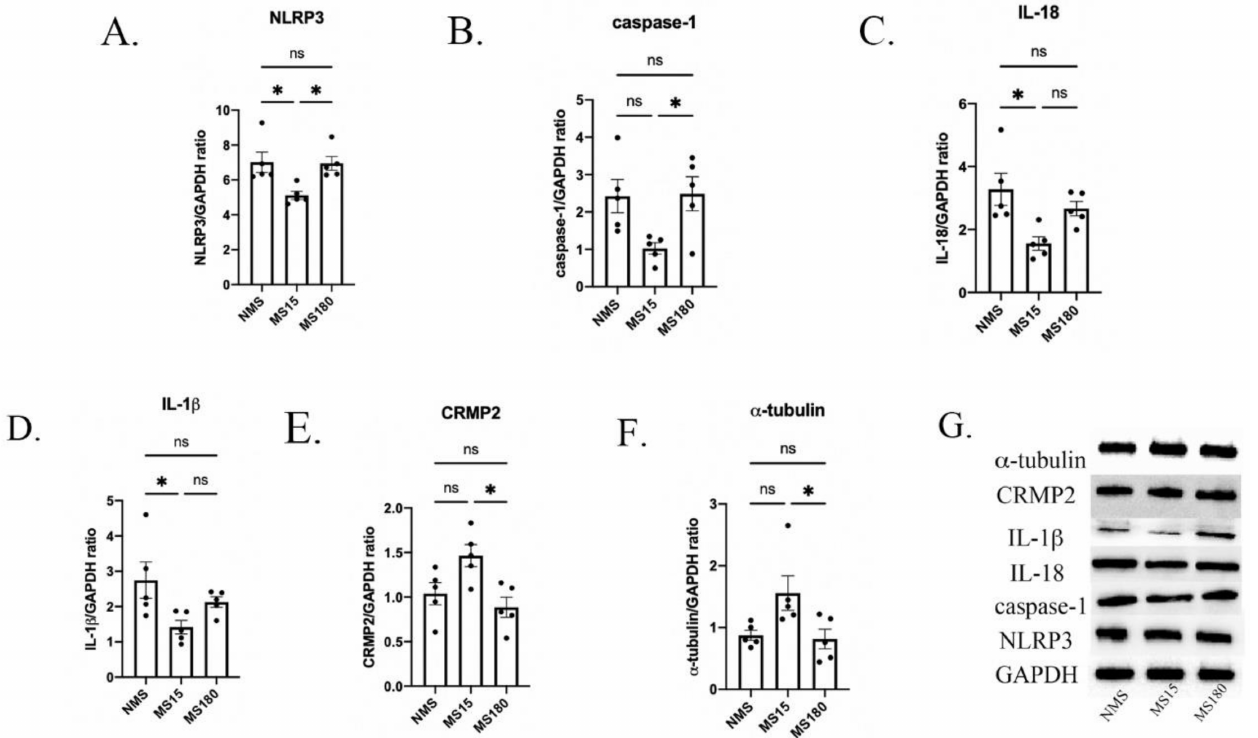
Figure 7. Hippocampal protein levels of neuroinflammation and neuroplasticity biomarkers in IMQ- induced psoriasis-like female mice with different MS protocols. Western blot analysis of ( A ) NLRP3, ( B ) caspase-1, ( C ) IL-18, ( D ) IL-1 β , ( E ) CRMP2, and ( F ) α -tubulin protein expression. ( G ) Densitometry analyses of the bands. NMS, MS15 and MS180 groups were concluded. Each value represents the mean ± SEM. n = 5 animals per group. All 3 groups were analyzed using ANOVA followed by a post hoc analysis (ns p > 0.05, * p <